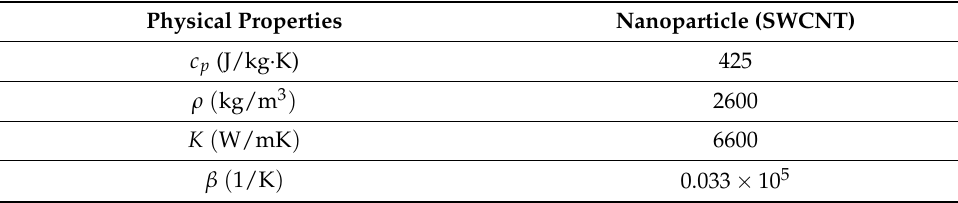
Figure 2. Computational domain mesh distribution. Table 1. Thermophysical characteristics of nanoparticles [25].